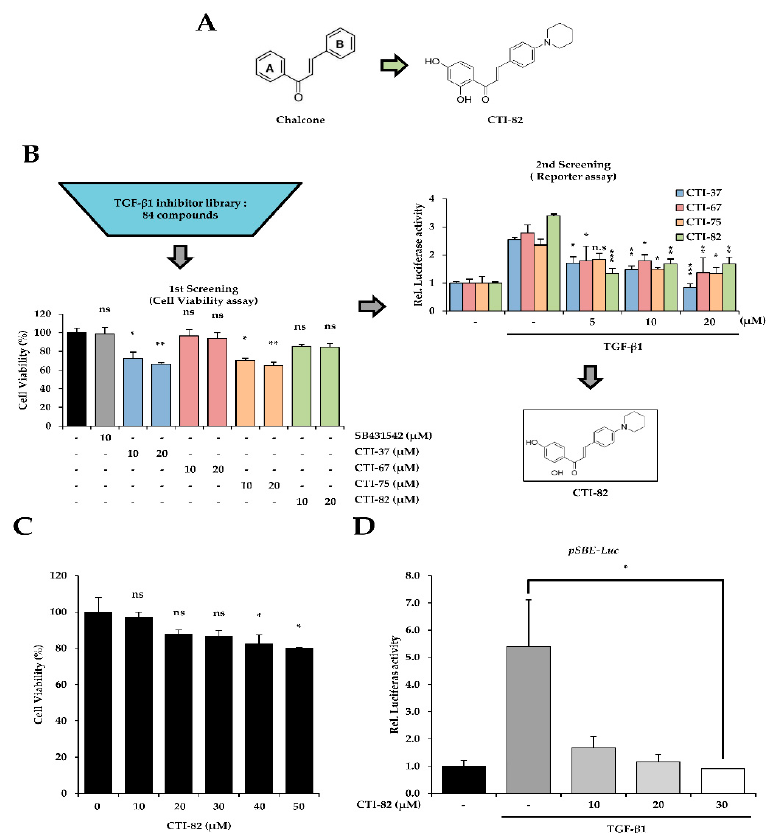
Figure 1. Profiles of the transforming growth factor- β 1 (TGF- β 1) inhibitor screen. ( A ) Structure